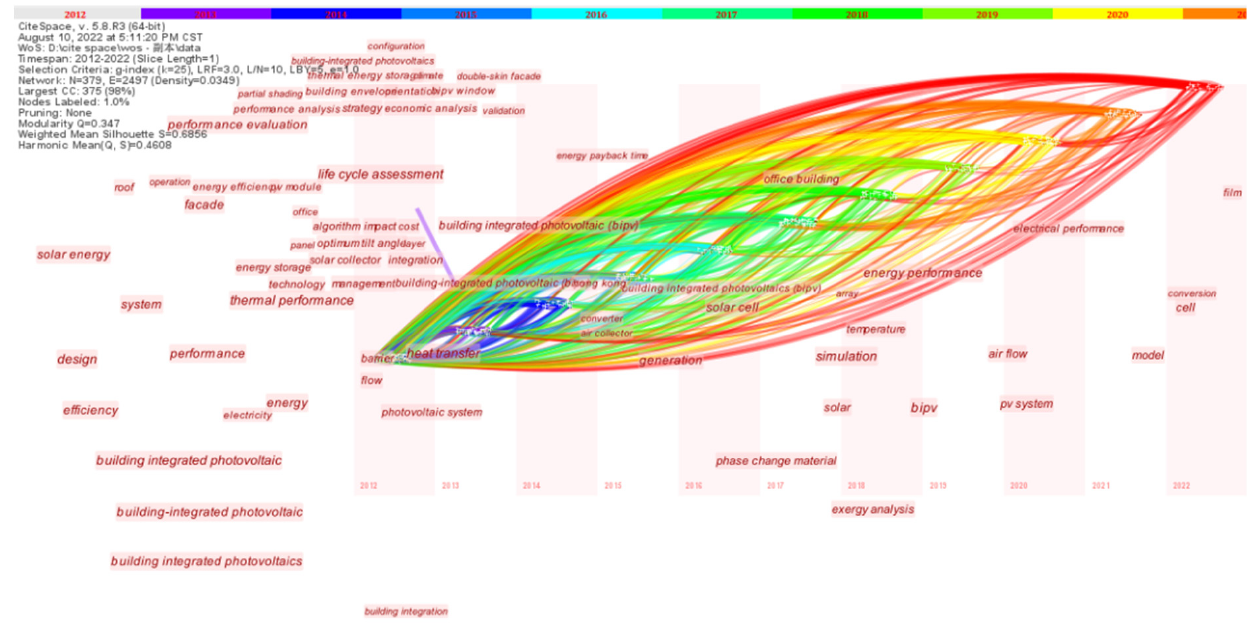
Figure 6. Keyword time zone map.